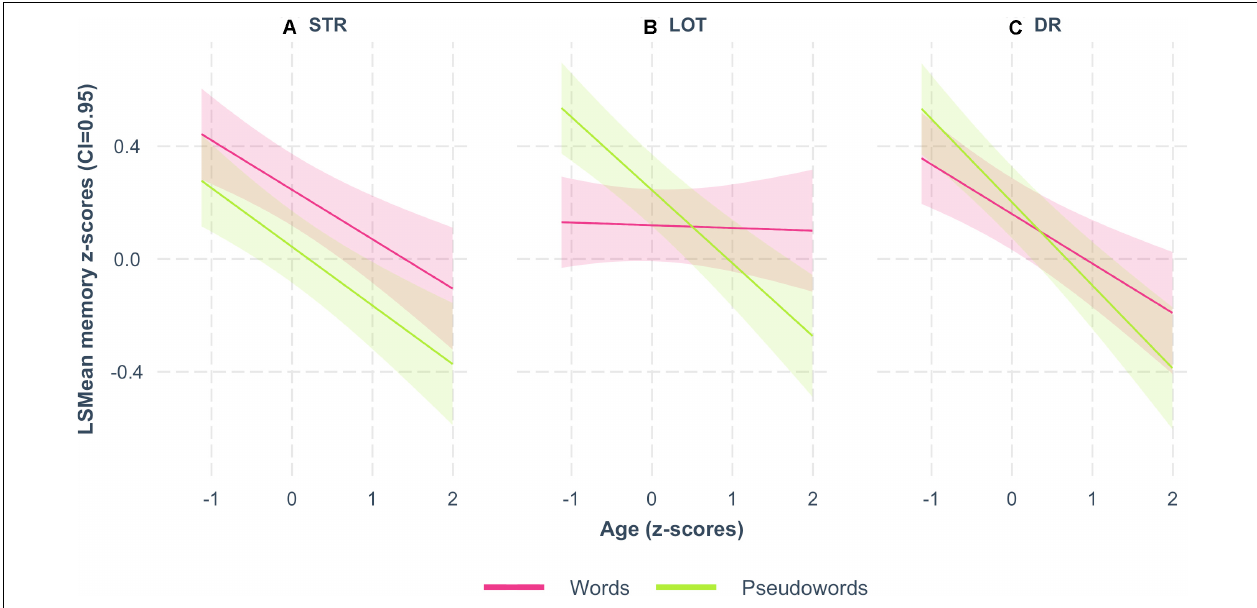
FIGURE 1 | Memory scores as a function of age. Age interaction with the type of item (pink: words; green: pseudowords) and 3 memory stages: (A) short-term recall – STR, (B) learning over trials – LOT, and (C) delayed recall – DR. All memory scores (LSmean of z-scores adjusted for sex, education, vocabulary scope, rhyming, WMC, and handedness) significantly decreased with age, except for the LOT of the words which remained stable.